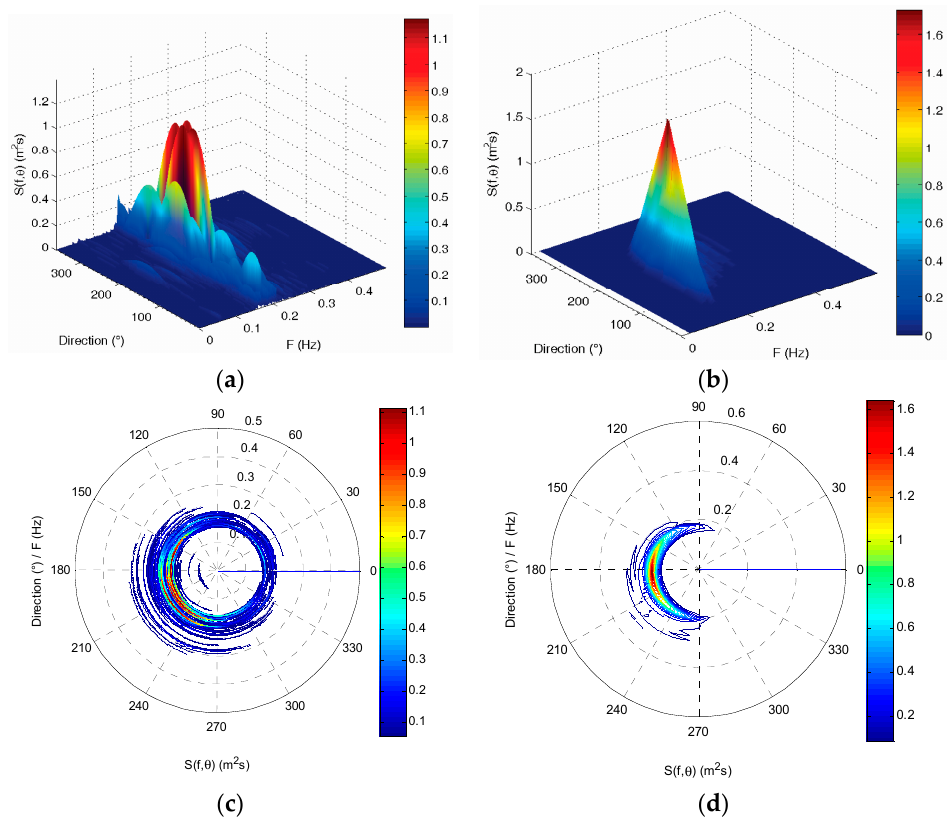
Figure 5. Comparison of directional wave spectrum between the SBF7-1A GPS wave buoy and the DWR-MKIII Waverider buoy before correction at 03:00 (UTC) on 2 July 2013: ( a , c ) directional wave spectrum of the SBF7-1A GPS wave buoy; ( b , d ) directional wave spectrum of the DWR-MKIII Waverider buoy.